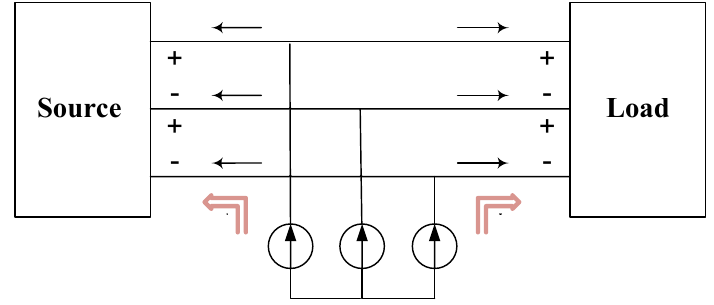
Figure 6. Current Perturbation Injected in Shunt.